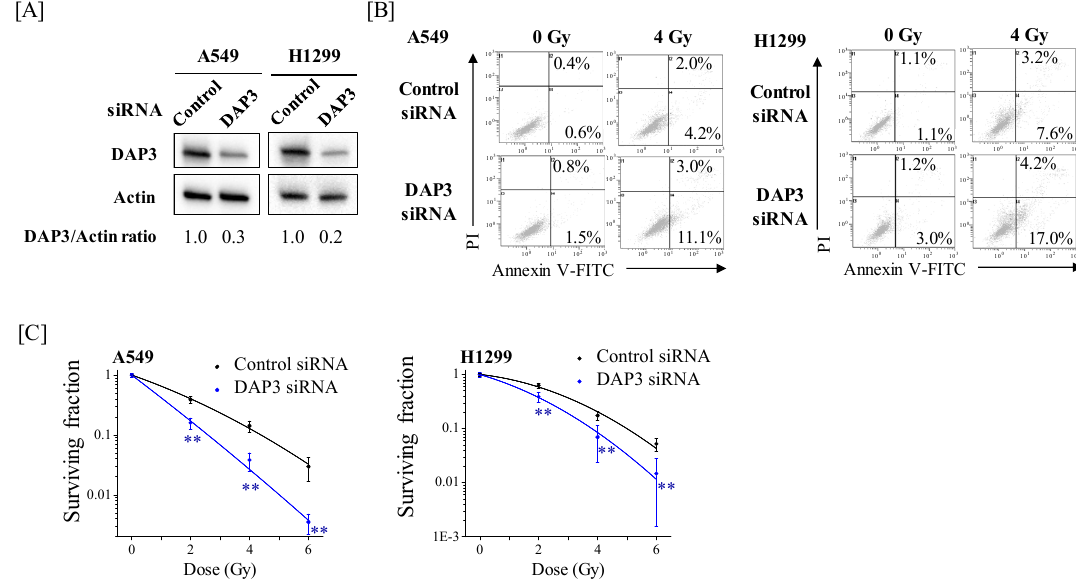
Figure 4. Effects of DAP3-knockdown on IR-induced cell death and radiosensitivity of human lung adenocarcinoma cells. ( A ) A549 and H1299 cells transfected with control or DAP3 siRNA were harvested, and DAP3 protein expression was analyzed by western blotting. Representative images of immunoblots are shown. Actin was used as a loading control. The relative values of DAP3/actin ratio are presented. ( B ) DAP3-knockdown A549 and H1299 cells were irradiated with 4 Gy. After culturing for 72 h, the cells were harvested for cell death analysis using annexin V-FITC/PI staining. Representative cytograms of annexin V/PI staining are shown. The inset numbers indicate the fractions of annexin V+/PI − or annexin V+/PI+ cells. ( C ) DAP3-knockdown A549 and H1299 cells were irradiated with X-rays. After a 20-h incubation, the cells were harvested and seeded in fresh media and further cultured until noticeable growth. The surviving fraction of A549 and H1299 cells is shown. Data are presented as mean ± SD of three independent experiments. ** p < 0.01 versus control siRNA.